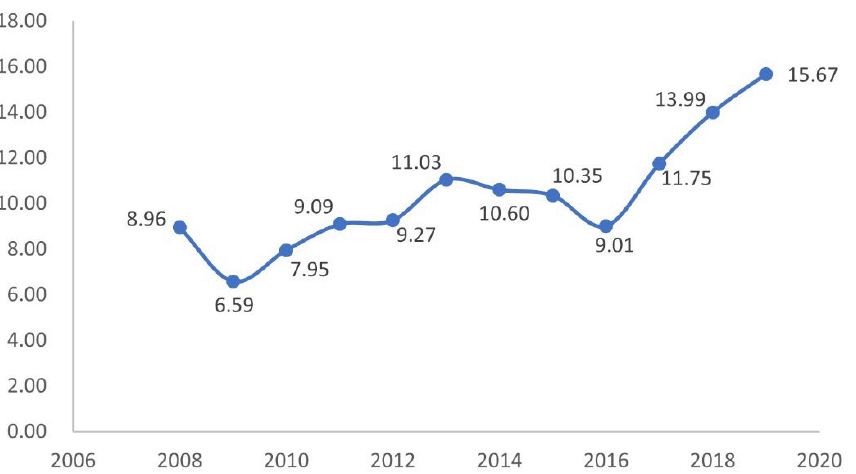
Figure 3. 2008–2019 Diagram of economic benefit value of water footprint of Tarim River basin. Unit: